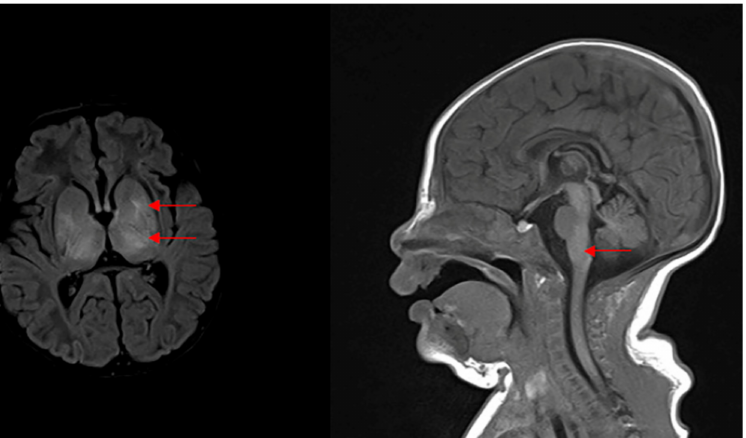
Figure 2. The brain magnetic resonance imaging (MRI) in P9 (Table 4) exhibited bilateral ab- normalities of the basal ganglia, thalamus, and brainstem, which are involved in the nucleus of vestibulocochlear nerve with clinical stage III hypoxic–ischemic encephalopathy and profound hearing